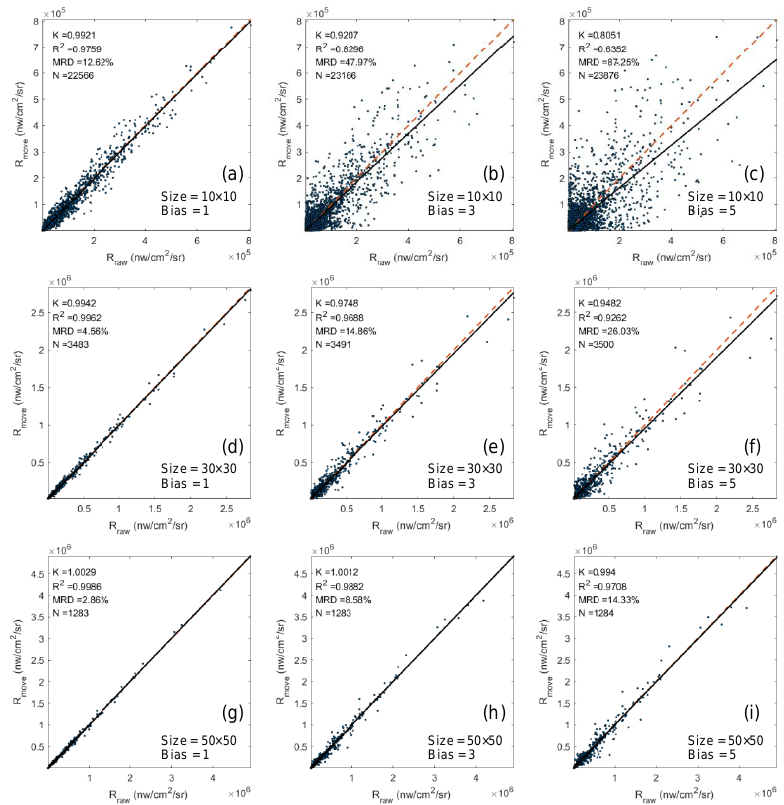
Figure 4. Relationship between selected grid size and positioning error. ( a – c ) are the regression di- agrams of the total radiance of light pixels in the grid when the grid size was 10 pixels and the position moved by 1, 3 , and 5 pixels, respectively. ( d – f ) are the regression graphs of the total radi- ance of the light pixel in the grid when the grid size was 30 pixels and the position moved by 1, 3, and 5 pixels, respectively. ( g – i ) are the regression graphs of the total radiance of the light pixel in the grid when the grid size was 50 pixels and the position moved by 1, 3, 5 pixels, respectively. Similar to VIIRS/DNB, AOD inversion using SDGSAT-1/GLI data also requires the appropriate pre-processing of city lights. Due to the influence of atmospheric conditions, radiometric calibration, moon phase, and observation geometry, the radiance value of the same pixel may vary on different days. Light pixels with a DN value greater than 20 were considered relatively stable and were classified as urban light pixels based on the charac- teristics of the SDGSAT-1/GLI night light data. Here, the number of stable light pixels in the same window was considered a constant, which can be quantified by the median of the multi-day observation. The median number of urban light pixels observed from mul- tiple days in each window was considered to be the total number of real urban light pixels in the window in 𝑁 𝑚 . This method could maintain the stability of the selection and en- hance the comparability of the low light data.